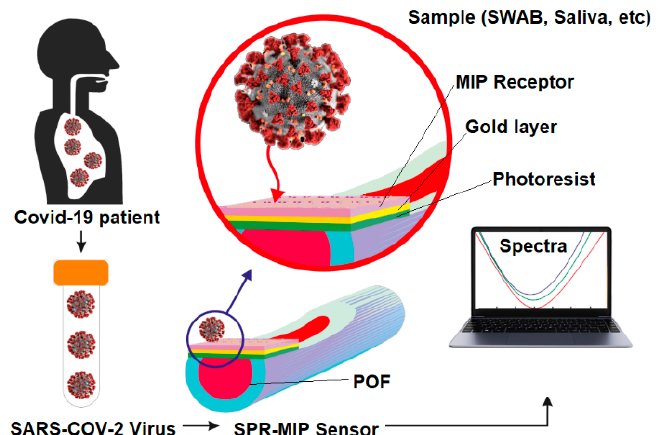
Figure 1. Outline of the Sensor for SARS-CoV-2 detection in different matrices.